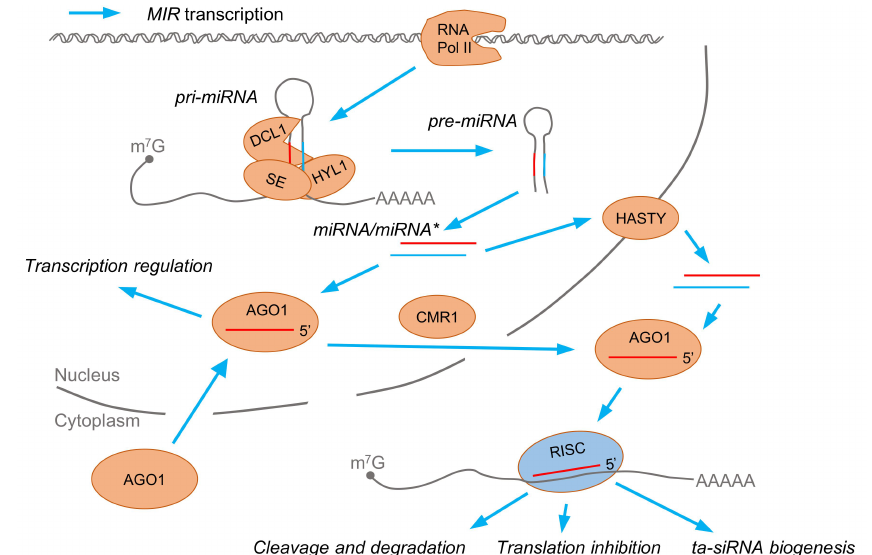
Figure 1. Biogenesis and functions of microRNAs in plants. MicroRNA genes ( MIR ) are transcribed by RNA polymerase II (RNA Pol II) to primary transcripts of microRNA (pri-miRNA) precursors. Pri-miRNAs are cleaved by a microprocessor complex with a core of DICER-LIKE1 (DCL1), HYPONASTIC LEAVES1 (HYL1), and SERRATE (SE). The intermediate steps of microRNA biogenesis are pre-miRNA forming a hairpin structure and the microRNA/microRNA* duplex. MicroRNA bound to AGO1 is exported from the nucleus in a CMR1-dependent way, while HASTY drives microRNA/microRNA* duplex export. MicroRNA directs AGO1 to play its roles in mRNA cleavage or translation inhibition, trans-acting short-interfering RNA (ta-siRNA) biogenesis, and transcription